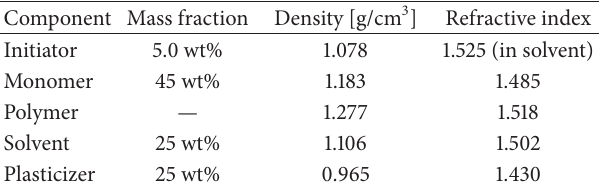
Table 3: Experimental conditions.